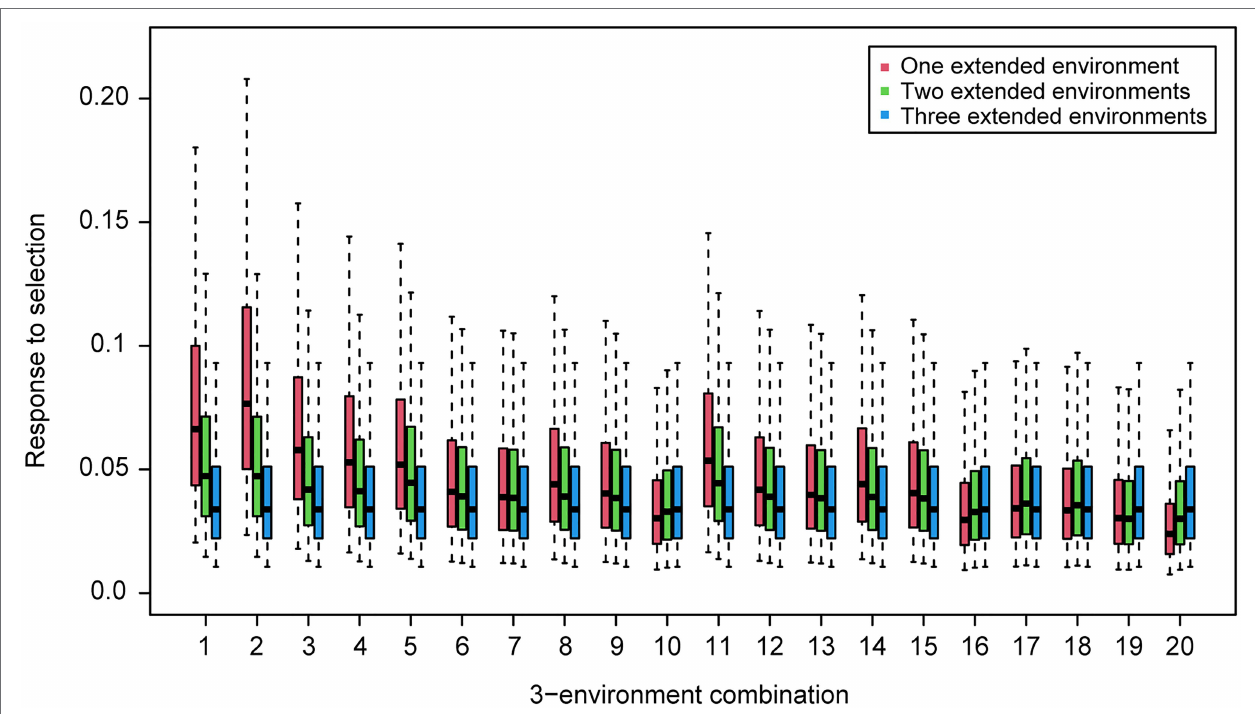
FIGURE 6 | Wheat – responses to selection of 4-environment (one extended environment), 5-environment (two extended environments) and 6-environment (three extended environments) sparse phenotyping combinations belonging to each 3-environment complete phenotyping combination. Labels of horizontal axis are the scenario numbers of 3-environment